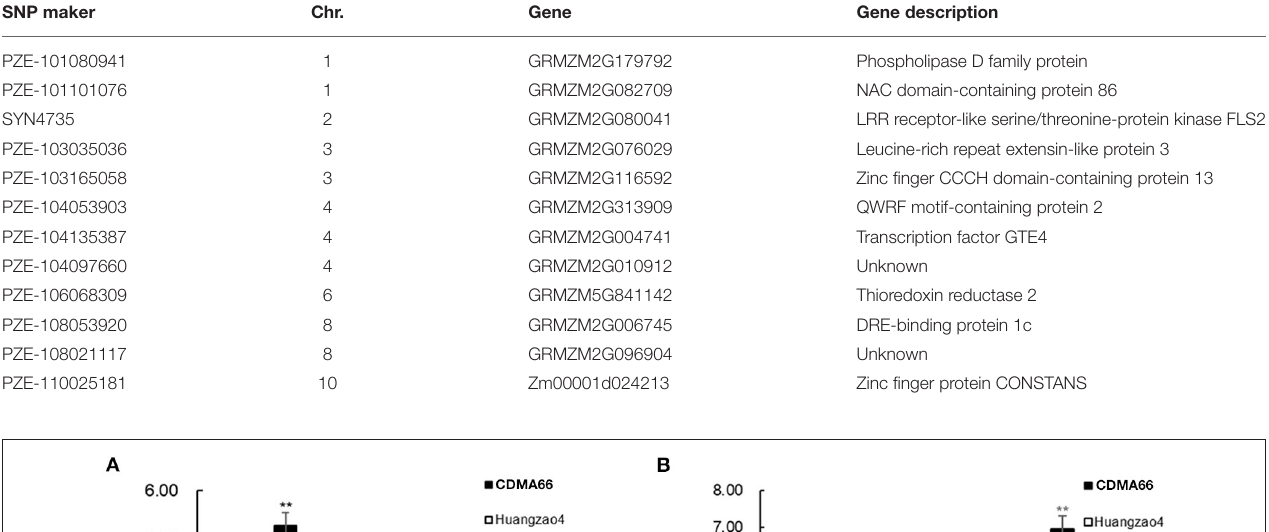
TABLE 4 | Information of candidate genes for resistance to maize stalk rot.